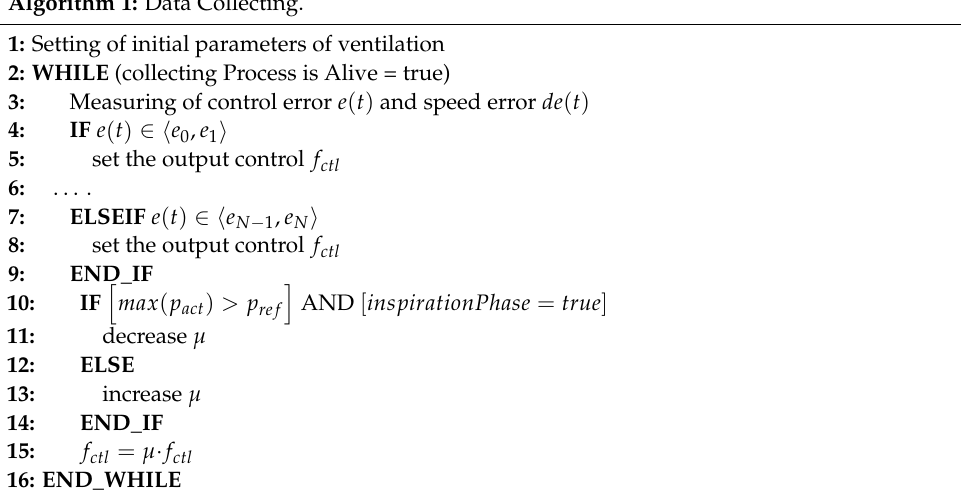
Algorithm 1: Data